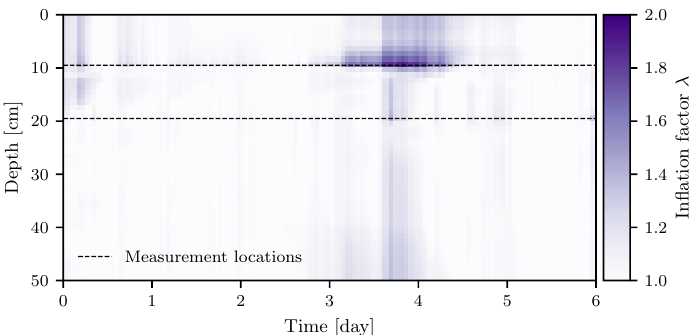
Figure 2. Inflation factor for the water content state. The inflation is strongest at the upper measurement location during the infiltration, when the uncertainty is underestimated the most. The inflation factor is transferred to the other measurement locations through the correlations in the Kalman gain. The used interpolation of Miller scaling factors impacts these correlations and leads to the smaller inflation directly below the measurement locations.